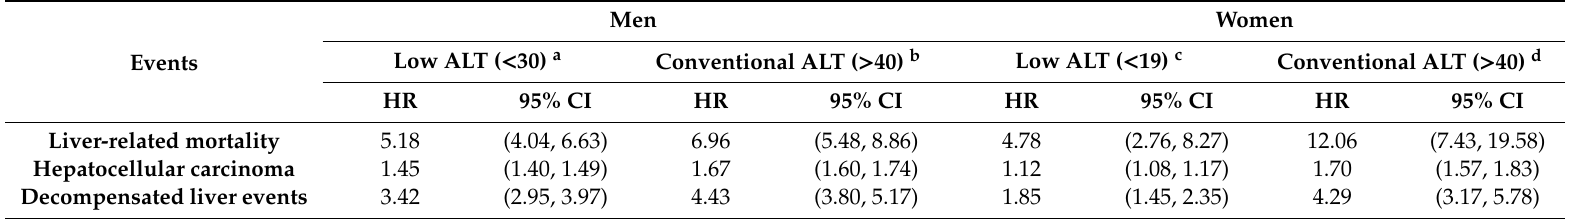
Table 2. Hazard ratios for liver outcomes by low (30 U / L) and conventional (40 U / L) alanine aminotransferase cut-o ff values in men and women, estimated using